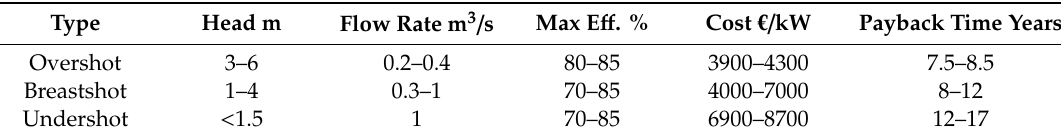
Table 1. Typical characteristic data of gravity water wheels (GWWs). Cost refers to energy production (see [16] for details).